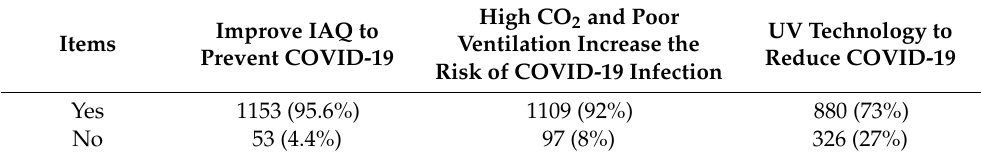
Table 4. Knowledge of IAQ and COVID-19.